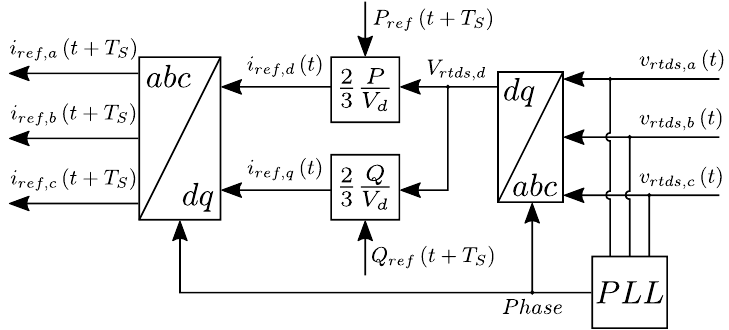
Figure 8. Calculation of the current